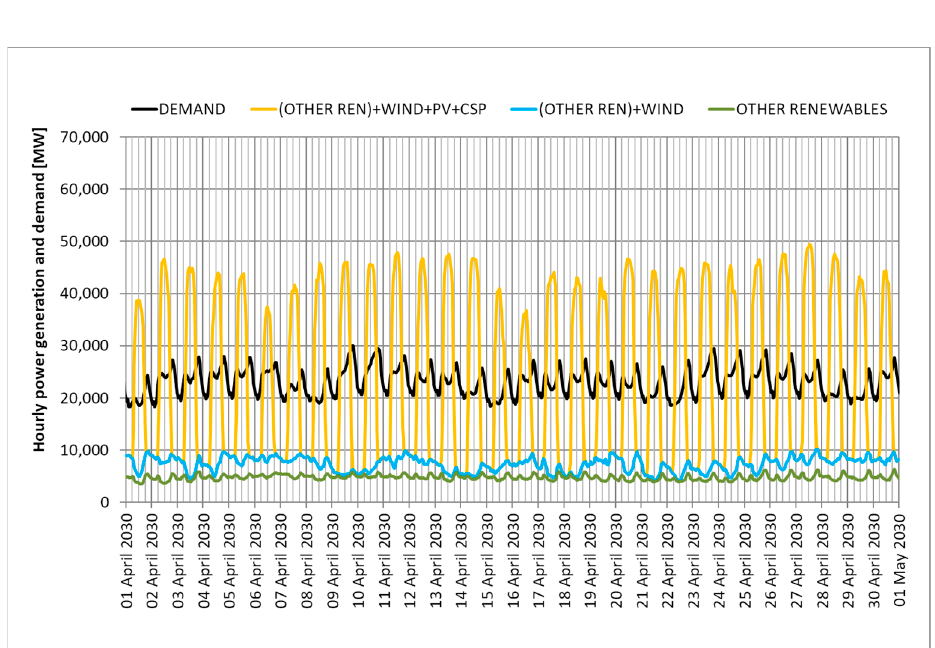
Figure 2. Projected hourly electricity demand and potential generation (i.e., pre-curtailment and storage) for the month of April 2030, in the “BAU” (business as usual) scenario.